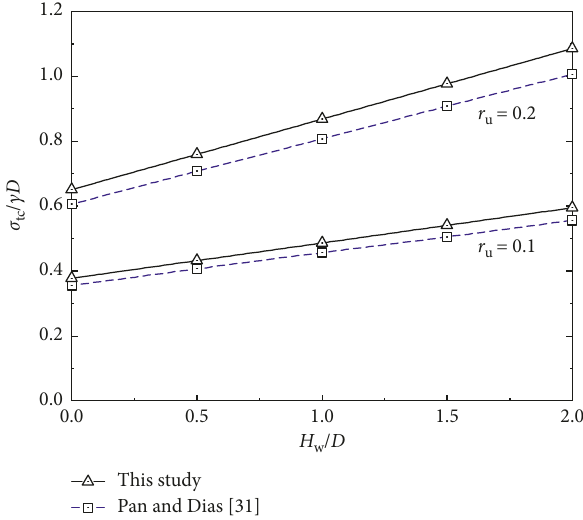
Figure 5: Comparison of the critical results for tunnel face sub- jected to pore water pressure ( c 0 kPa and φ 35 ° ). (cid:29) (cid:29) Table 2: Comparison of the calculated values of σ c D between tc / this study and Wong and Subrin [29] for tunnels in purely frictional soils. Wong and Subrin